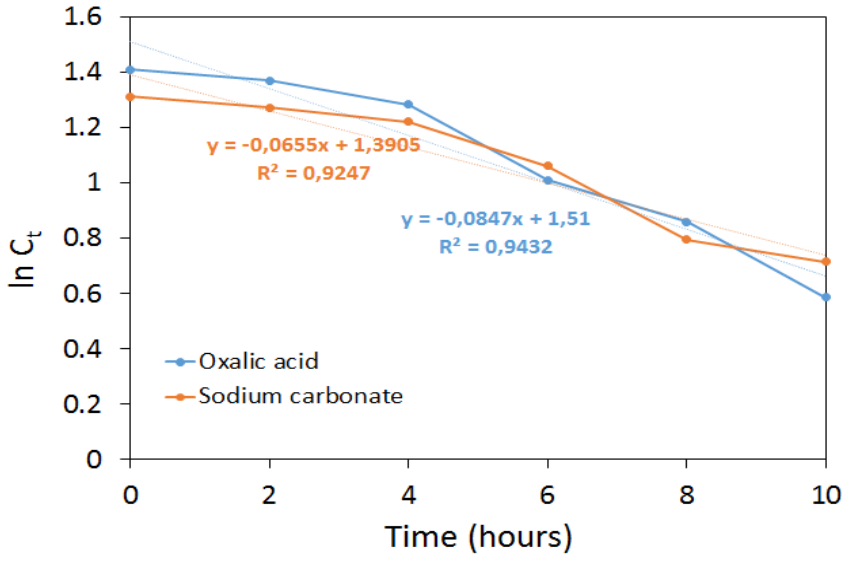
O with precipitation agents variation. 2 3